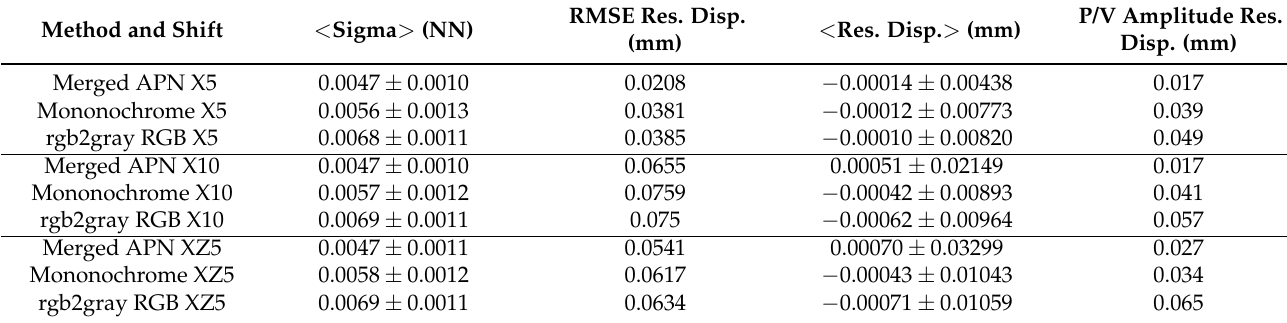
Table 4. Demosaicking evaluation for Street